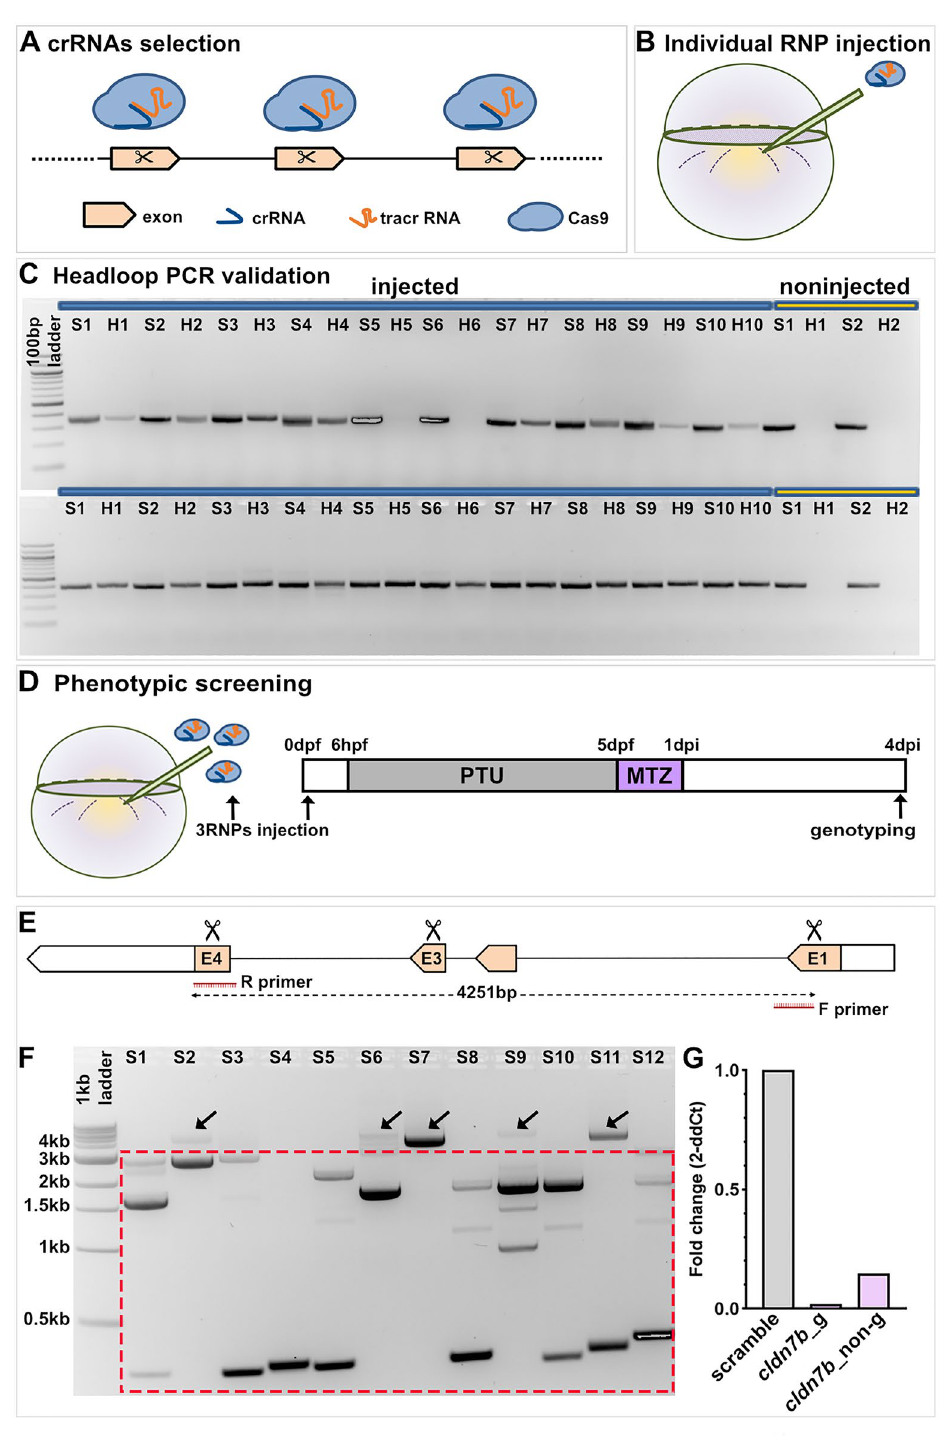
Figure 1. F0 screening pipeline to identify genes regulating RPE regeneration. ( A ) Design and selection of crRNAs. ( B ) Injection of individual RNP complexes (gRNAs (crRNA:tracrRNA) with Cas9 protein) into rpe65a :nfsB-eGFP embryos. ( C ) Example electrophoresis results of headloop PCR (H) targeting zgc: 153911 (top gel) and nrg1 (bottom gel) in parallel with standard PCR (S) from ten RNP-injected embryos and two uninjected controls. Mutagenic rate = H+/S+ number of embryos. Mutagenic rate for zgc: 153911: 80%; for nrg1 : 100%. ( D ) Schematic of the injection/ablation and screening paradigm. ( E ) Schematic of cldn7b showing exon 1 (E1), 3 (E3), and 4 (E4) target loci (scissors) and PCR strategy to confirm intragenic deletions. ( F ) Example cldn7b data from individual RNP-injected larvae confirming intragenic deletions generated by simultaneously targeting three genomic sites. Gel bands within the dashed box indicate intragenic deletions. ~ 4 kb bands (arrows) represent either wild-type or mutated alleles with small indels. ( G ) Bar graph showing relative expression fold change of cldn7b from genotyped ( cldn7b _g) and non-genotyped ( cldn7b _non-g) F0 knockout larvae and scrambled controls. Each bar represents biological variation from n = 50 pooled larvae and technical variation from three replicates. Example gels shown in ( C ) and ( F ) have been color inverted and cropped for clarity and data presentation purposes. Original gel images are shown in Fig. S9. Abbreviations as follows: RNP, ribonucleoprotein; PTU, n-phenylthiourea; MTZ, metronidazole; hpf/dpf, hour/day (s) post-fertilization; dpi, day (s)